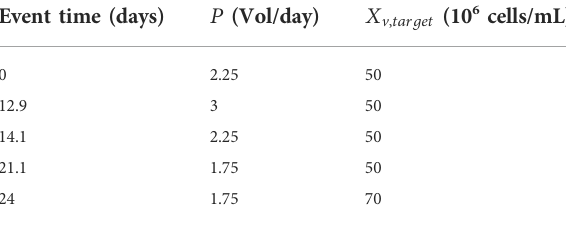
TABLE 3 Details of switch in process operations for perfusion simulation and experimental